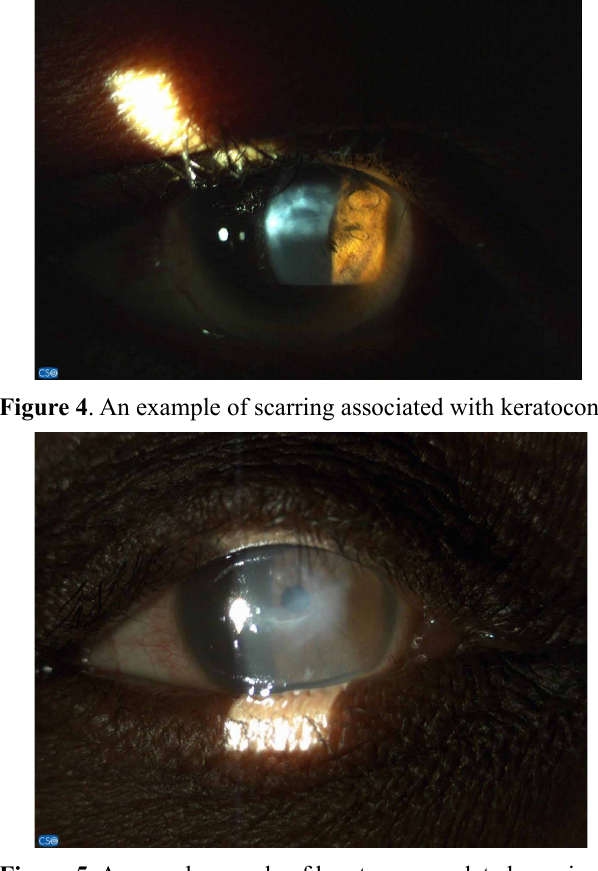
Figure 5 . A second example of keratoconus-related